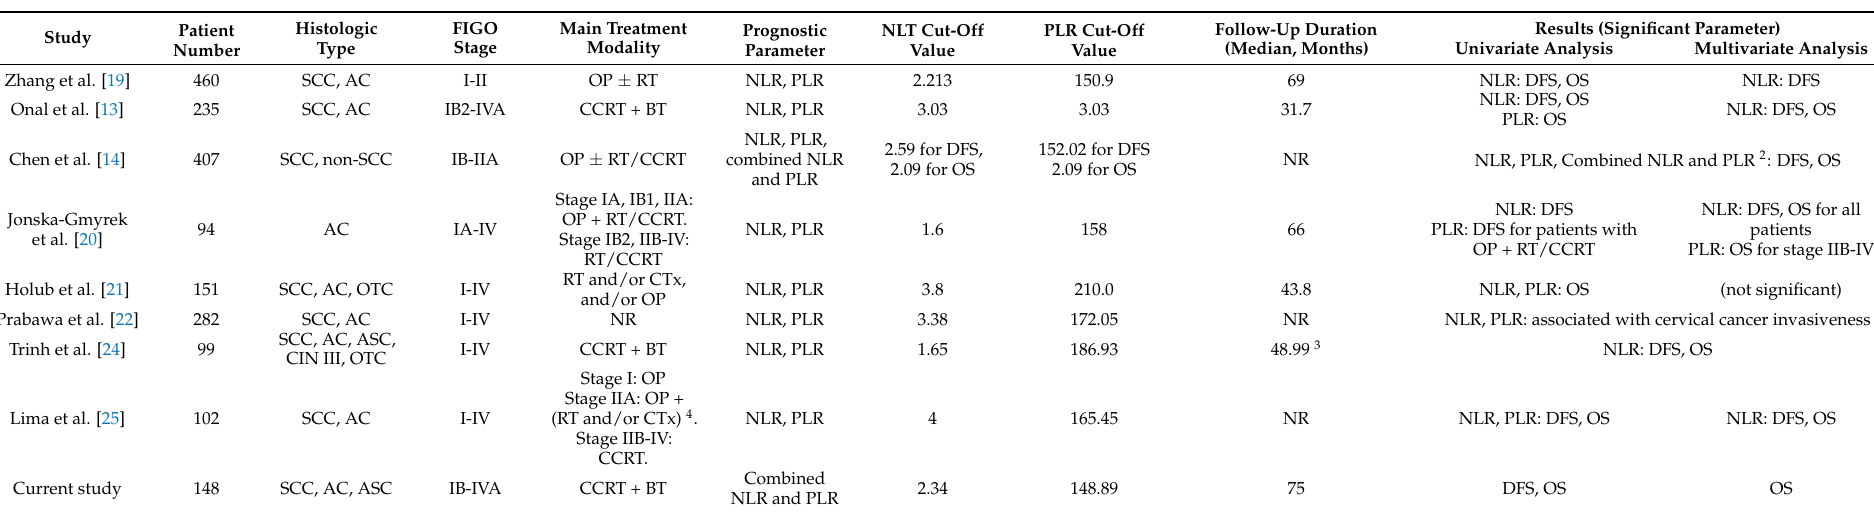
Table 5. Multivariate Studies analyzing the association between the prognosis and pretreatment NLR and/or PLR in cervical cancer 1